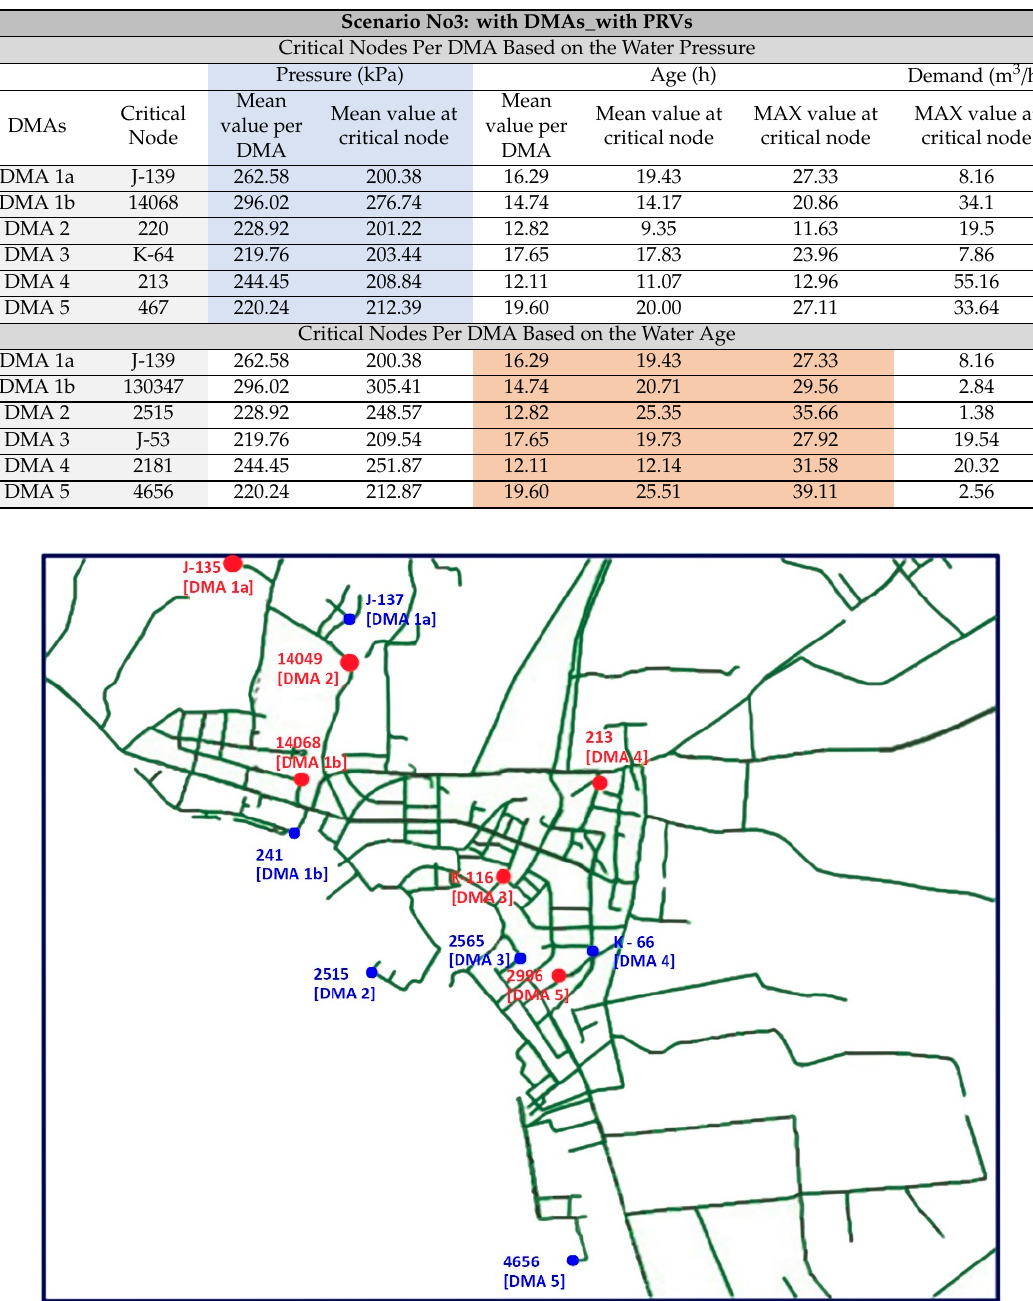
Table 3. Scenario No3 (with DMAs_with PRVs): (a) Critical nodes per DMA based on the water pressure. Respective water age and water demand values; (b) Critical nodes per DMA based on the water age. Respective water pressure and demand values.